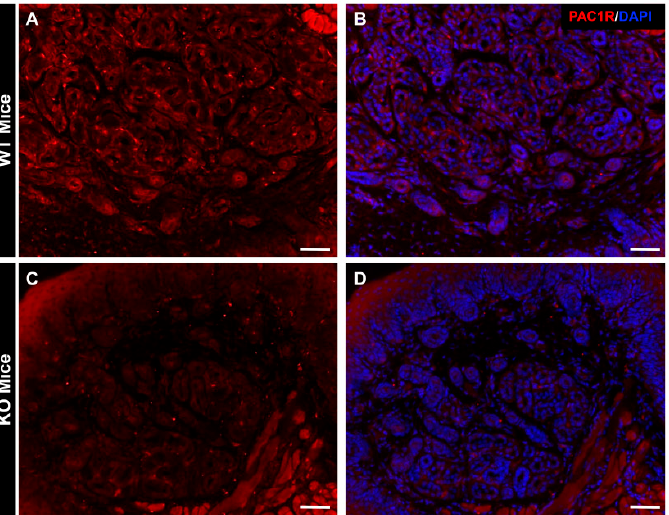
Figure 1. Analysis of PAC1R distribution in mouse eccrine gland. The WT mouse and PAC1R KO mouse skins were immunostained with PAC1R (red; A and C) and counter stained with DAPI (nuclei, B and D). Scale bar = 50 μ m.